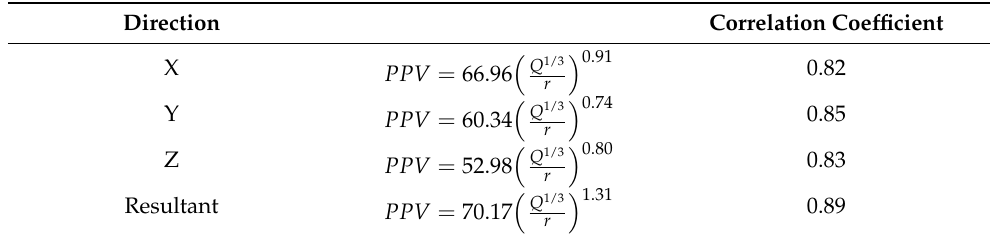
Table 4. PPV prediction model for each direction of the ground soil and correlation coefficient.